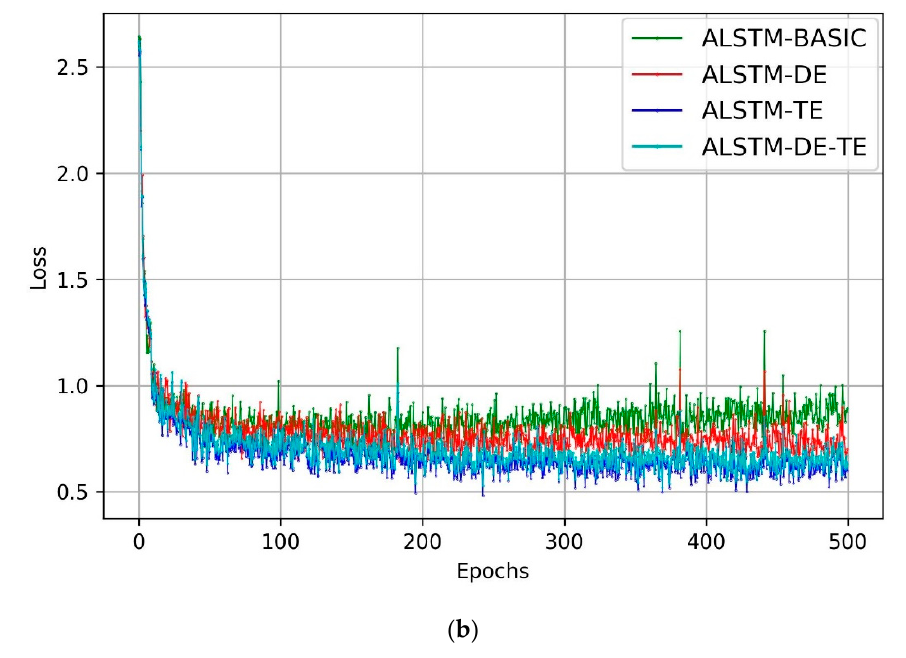
Figure 2. ( a ) Accuracy and ( b ) loss curve.